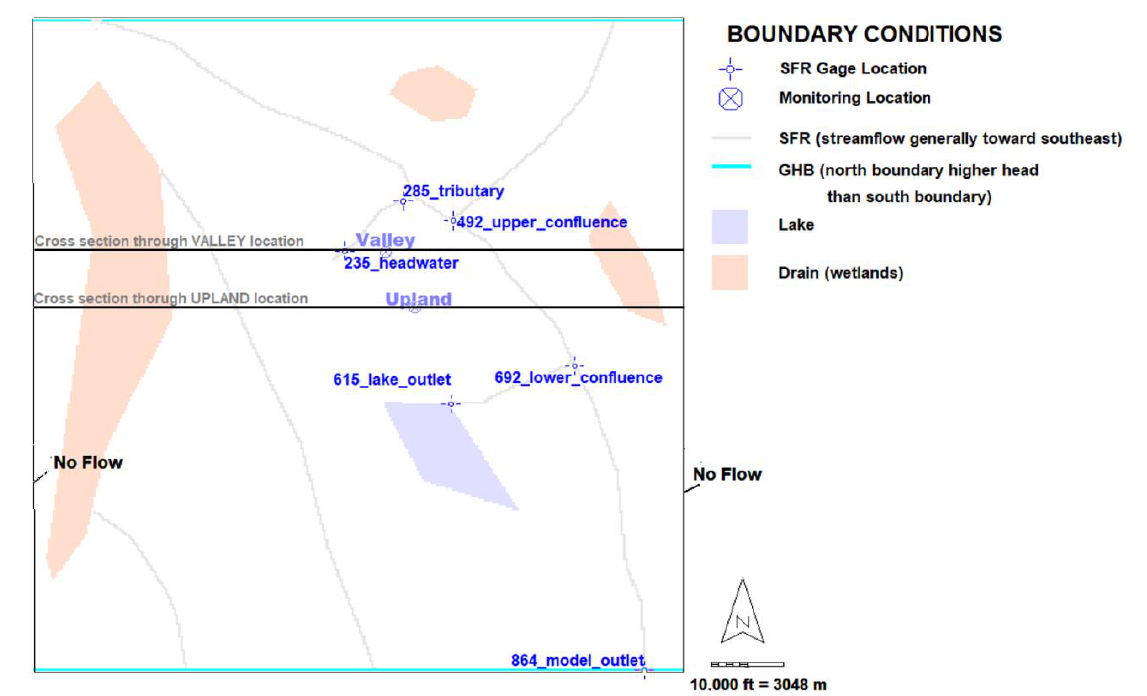
Figure 2. Plan view of synthetic model setup, showing boundary conditions (SFR: streamflow routing package; GHB: general-head boundary package; No Flow: no-flow boundary), locations for monitoring output, and the locations of cross-sections shown in the Supplementary Material (Figures S1–S9). Numbers associated with SFR gage locations correspond to IDs used later in the text. Table 1. Flow parameter values used in synthetic water model are spatially homogeneous.